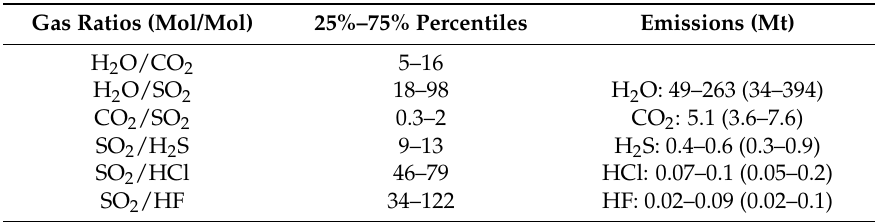
Table 2. Representative gas ratios over the duration of the eruption and the calculated emission of each gas relative to SO 2 based on the DOAS flux rate of 9.6 Mt SO 2 and in parentheses with the uncertainty range of 6.7–14.3 Mt SO 2